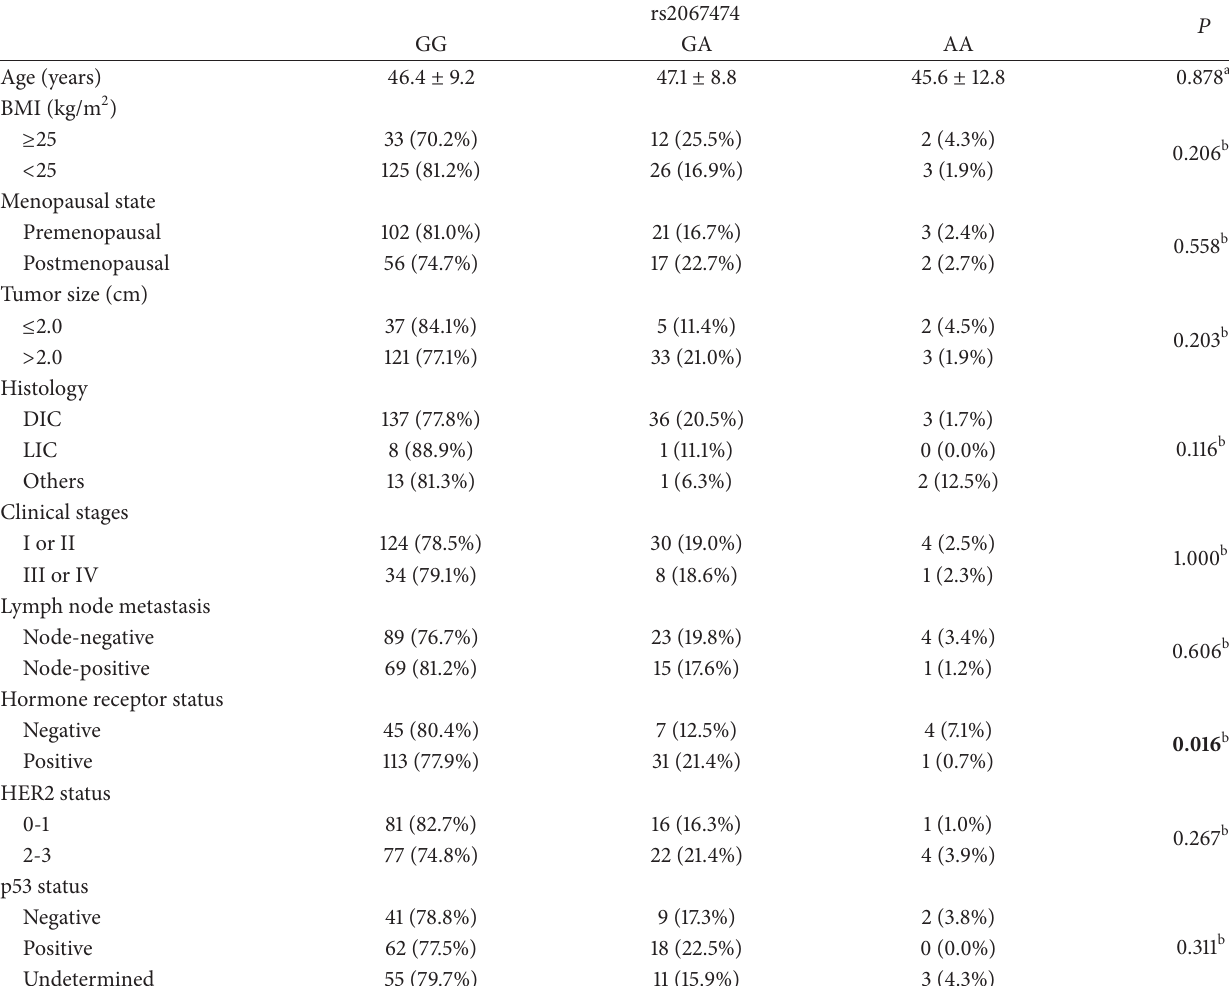
Table 4: Correlations of clinicopathological parameters and HRH2 rs2067474 polymorphism in patients with breast